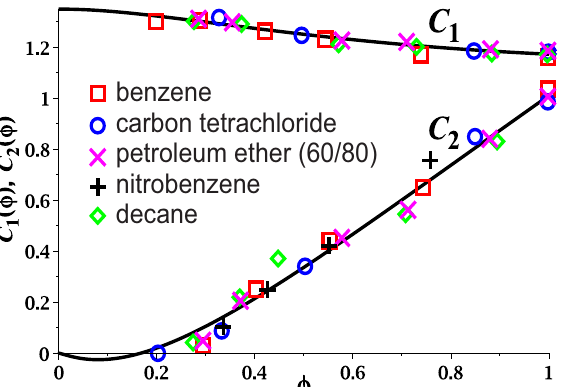
Figure 4. Dependence of the Mooney-Rivlin coefficients C 1 ( φ ) (upper curve) and C 2 ( φ ) (lower curve) on the volume fraction of polymer φ : theory (solid curves) and experimental data (points, Kg/cm 2 ) for swollen rubber